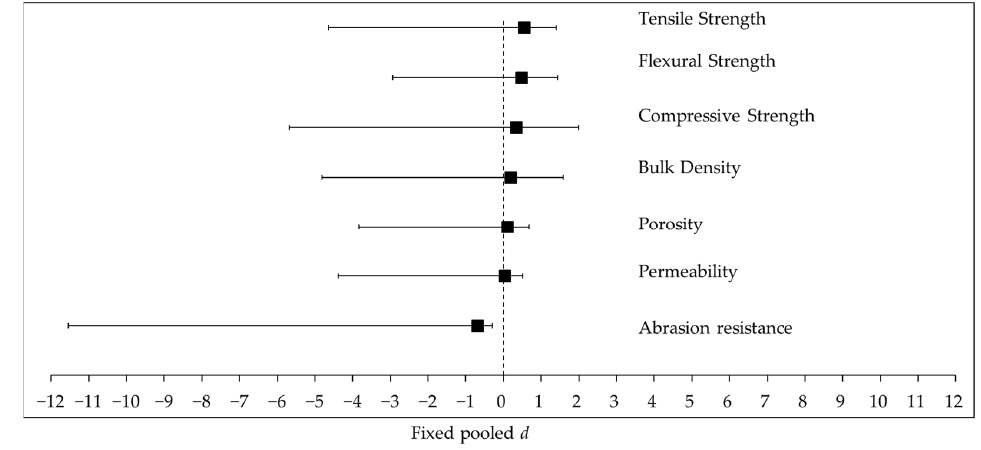
Figure 4. Overall performance of PC with different cement replacements based on fixed effect.